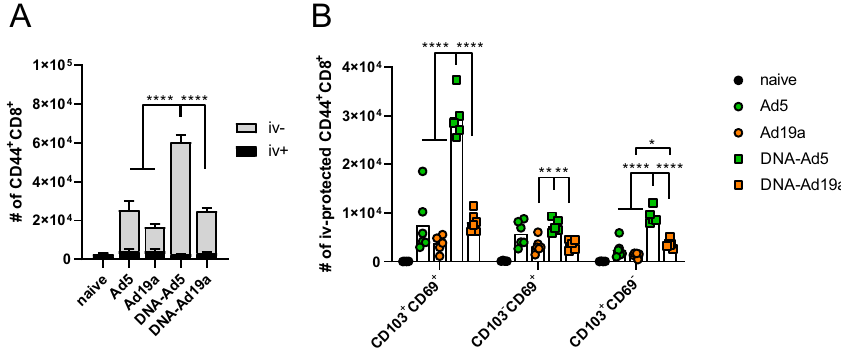
Fig. 3 Tissue-resident memory T cell subsets in the lung. BALB/c mice were vaccinated according to Fig. 1A. In absence of suitable MHC-I multimers, antigen-experienced CD8 + T cells were identi fi ed by CD44 staining ( A ). Intravascular staining was used to differentiate between circulating (iv + ) and tissue-resident (iv − ) memory cells. Tissue-resident phenotypes were assessed by staining for CD69 and/or CD103 within the iv-protected memory compartment ( B ). The gating strategy is shown in Supplementary Fig. 2. Bars represent group means with SEM ( A ) or overlaid with individual data points ( B ); naïve n = 4; DNA-Ad5 n = 5; other groups n = 6. Data were analysed by one-way ANOVA followed by Tukey ’ s multiple comparison test. Statistical signi fi cant differences are indicated only among the different the vaccine groups; p values indicate signi fi cant differences (* p < 0.05; ** p < 0.005; *** p < 0.0005; **** p < polyfunctional CD8 + T cells were detected in the spleens of DNA-Ad19a treated animals (Fig. 4C). Albeit at overall lower frequencies, the same observation was made for N-reactive CD8 + T cells in lungs and spleens (Supplementary Fig. 4A, C).